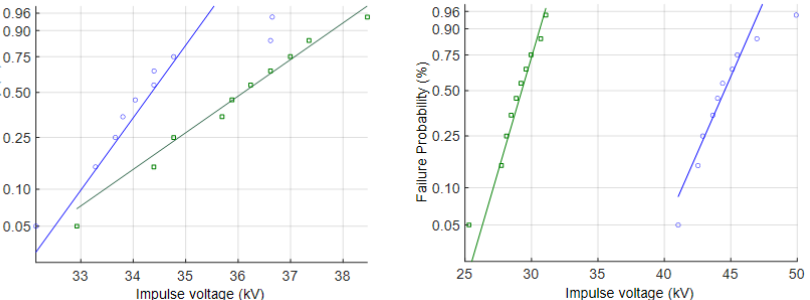
Figure 1. Positive ( left ) and negative ( right ) impulse breakdown voltage of a natural ester (green) and mineral oil